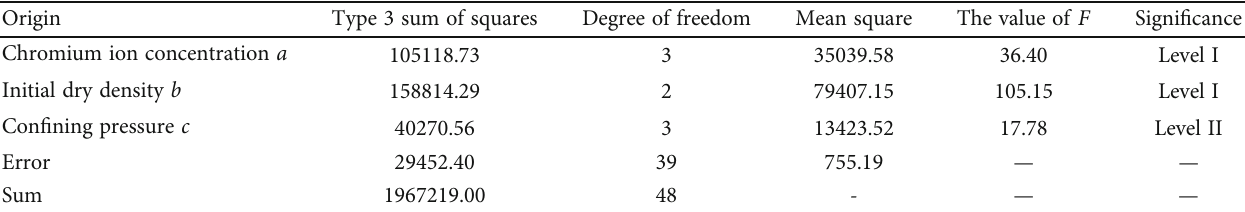
Table 5: variance analysis table of the degree of in fl uence of each in fl uencing factor on the peak deviator stress (without considering the interaction e ff ect).